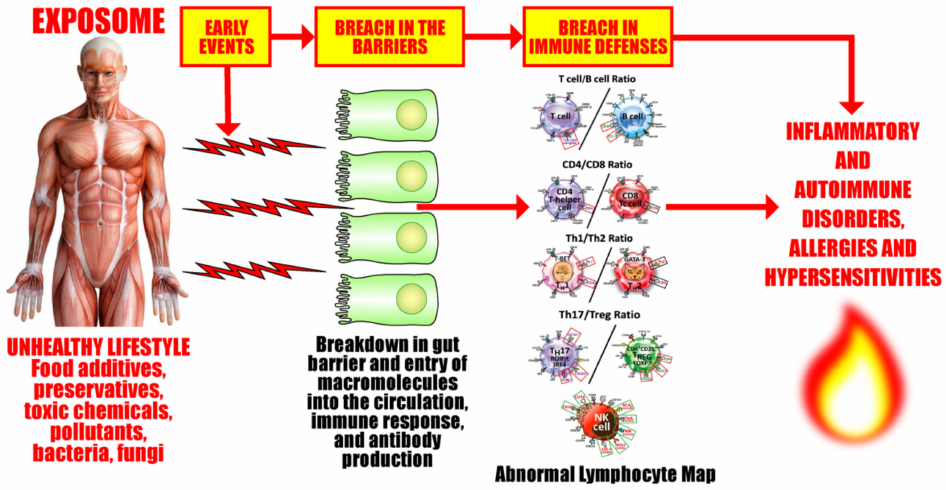
Figure 16. Exposome factors and early events that are involved in the breach of barriers and immune defenses that are associated with inflammatory, autoimmune, neurodegenerative disorders, allergies, and